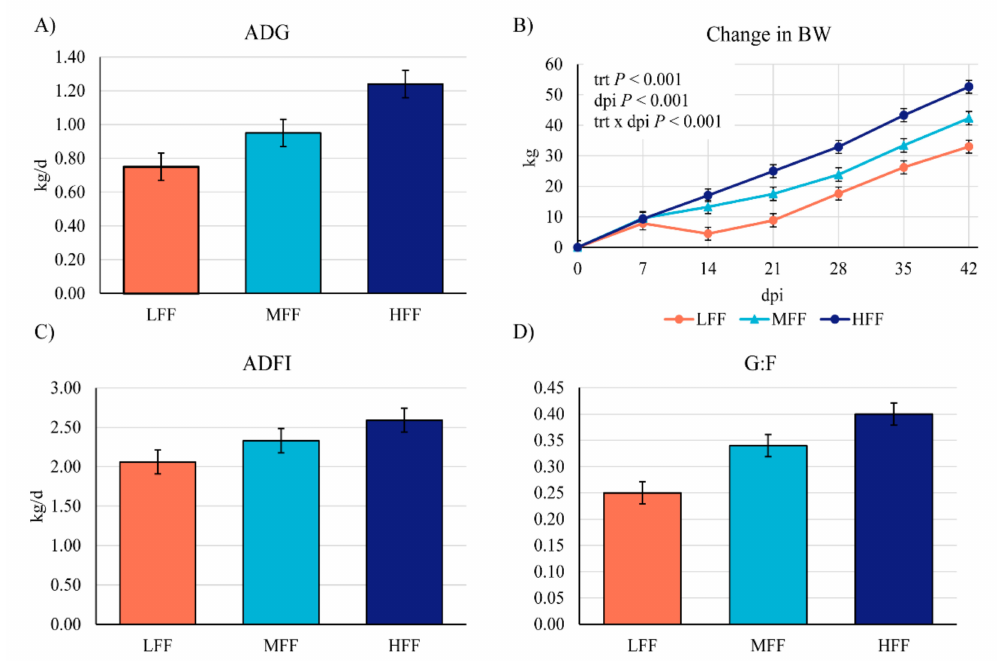
Figure 1. Overall (0–42 days post inoculation (dpi)) average daily gain, change in BW, average daily feed intake and feed efficiency (G:F) of pigs inoculated with Brachyspira hyodysenteriae and fed a lowly fermentable diet (LFF), an intermediate fermentability diet (MFF), and a highly fermentable diet